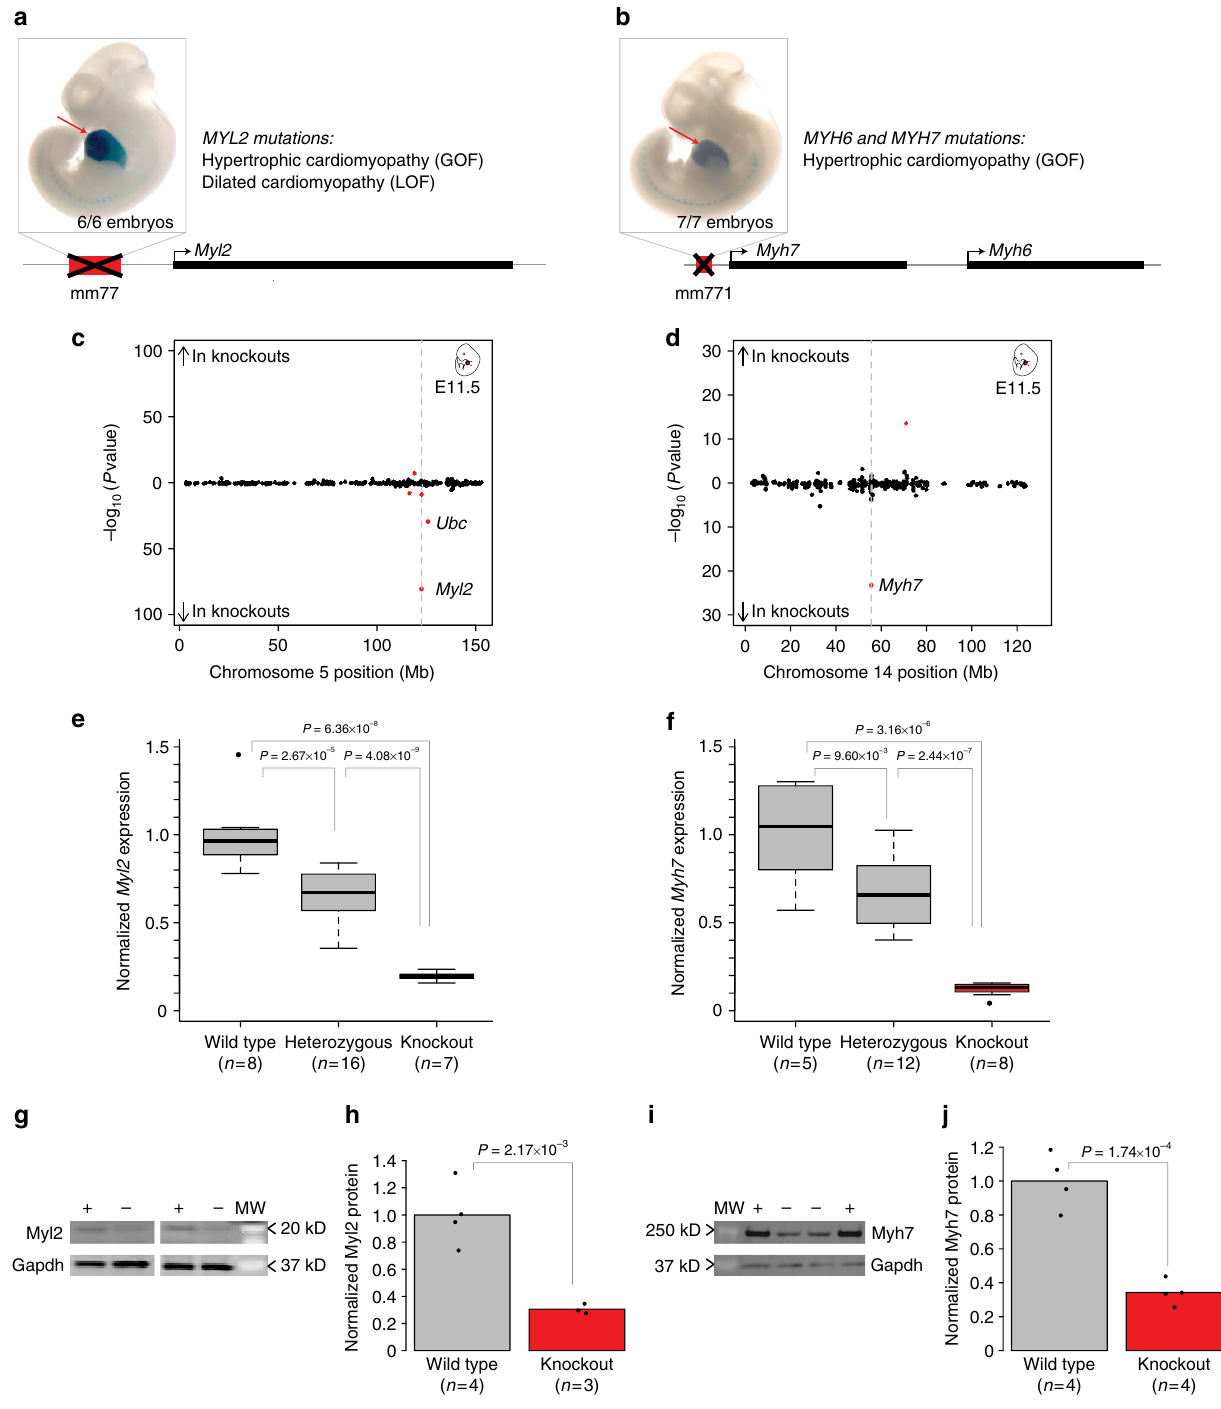
Figure 4 | Cardiac enhancers are required for normal expression of heart disease-associated genes. Knockout analysis of enhancers mm77 ( a , c , e , g , h ) and mm771 ( b , d , f , i , j ). ( a , b ) Representative transgenic reporter assay results. Heart activity is indicated by red arrows. Numbers indicate reproducibility over total transgenic embryos. Gene models not drawn to scale. LOF: loss-of-function, GOF: gain-of-function. ( c , d ) Chromosome-wide mRNA expression changes in E11.5 whole heart. Points indicate individual genes, with red indicating statistically significantly differences after FDR correction ( P o 0.01 using an FDR o 5%, see the ‘Methods’ section for details). Dashed grey line indicates position of enhancer. Mb: megabases. ( e , f ) Normalized mRNA levels measured by quantitative RT-PCR in E11.5 hearts. Boxplots indicate median and quartile values for each data set; points indicate outliers. ( g – j ) Representative western blot images ( g , i ) and normalized protein levels ( h , j ) in wild-type ( þ ) and homozygous null ( (cid:3) ) samples. Gapdh was used as a loading control, MW, molecular weight. ( g , i ). Bars indicate group means, and points represent biological replicates ( h , j ). For ( e , f , h , j ): values were normalized to the wild-type mean, and P values were calculated using a one-tailed t